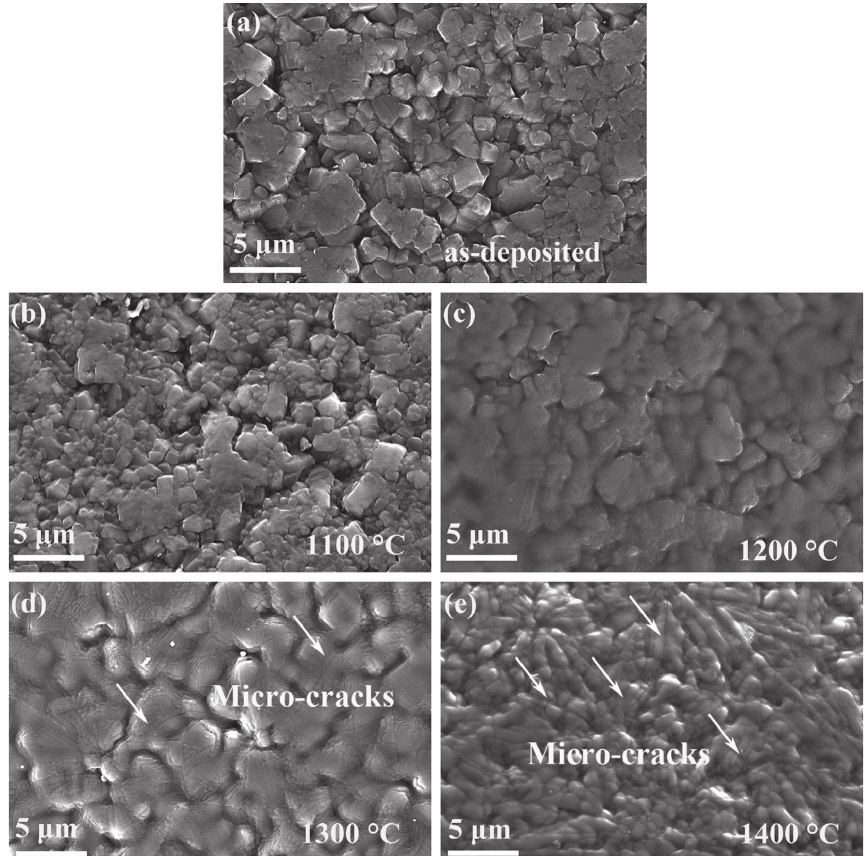
Figure 2: The outer-surface SEM morphology of the SiC layers of (a) as-deposited and after exposure in air at a temperature of (b) 1100 °